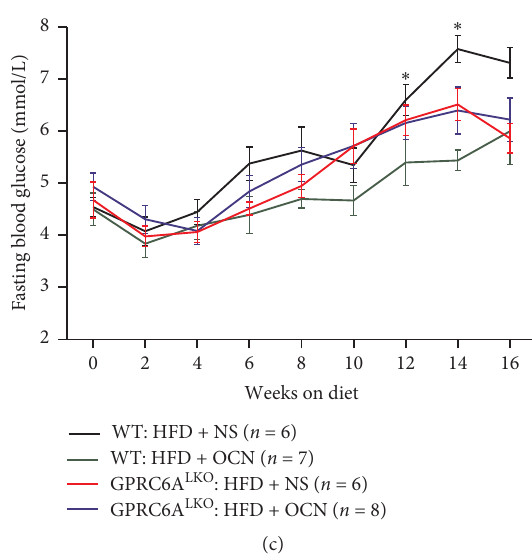
Figure 1: The effects of osteocalcin and GPRC6ALKO on body weight and fasting blood glucose. (a) Verification of GPRC6ALKO through western blotting; (b) body weight (g); (c) fasting blood glucose levels (mmol/L). GPRC6ALKO mice or WTmice were fed with HFD diet and treated daily with 30 ng/g/day uncarboxylated osteocalcin or saline solution. Data were expressed as the mean ± SEM and were analyzed by independent-samples T -test. ∗ P < 0 . 05, the WT: HFD+OCN group compared with the WT :HFD+ NS group. GPRC6ALKO, liver- specific conditional GPRC6A knockout; WT, wild-type; NS, saline solution; HFD, high-fat diet; OCN, osteocalcin. The effects of osteocalcin and GPRC6ALKO on glucose tolerance and insulin